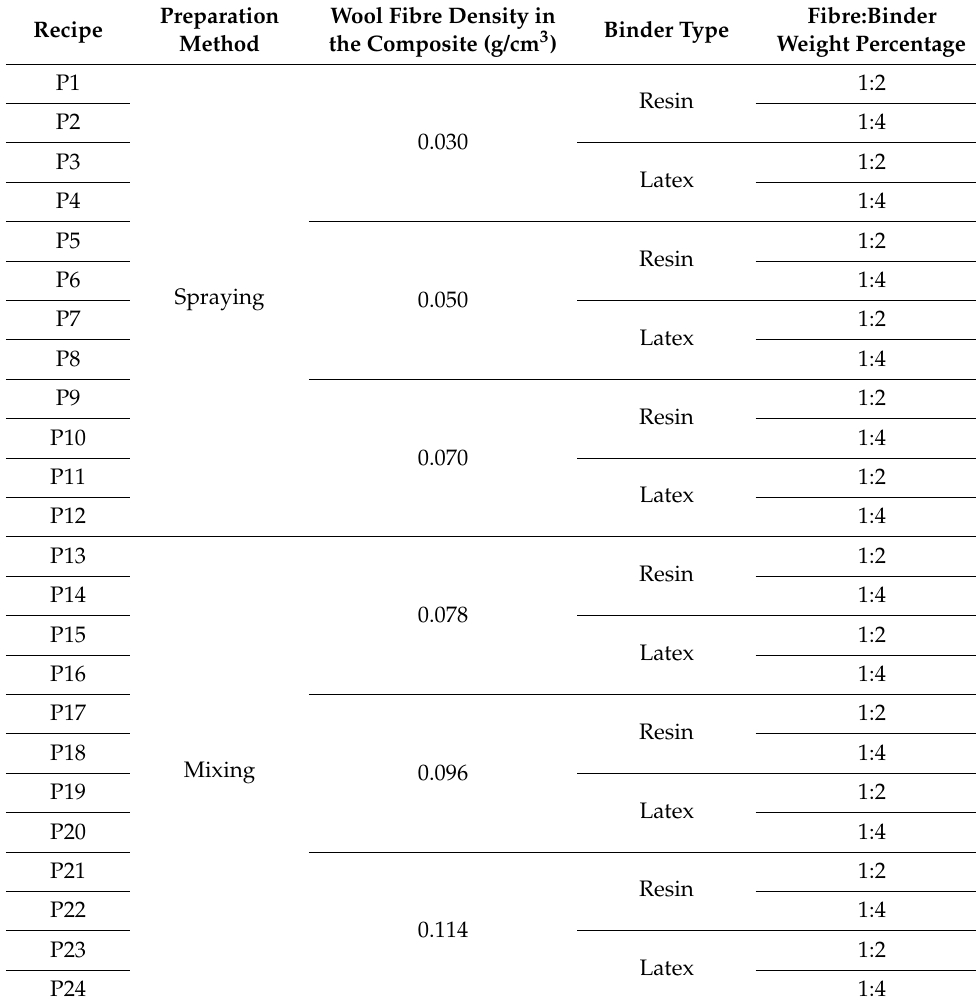
Table 2. Recipes of materials for wool-binder